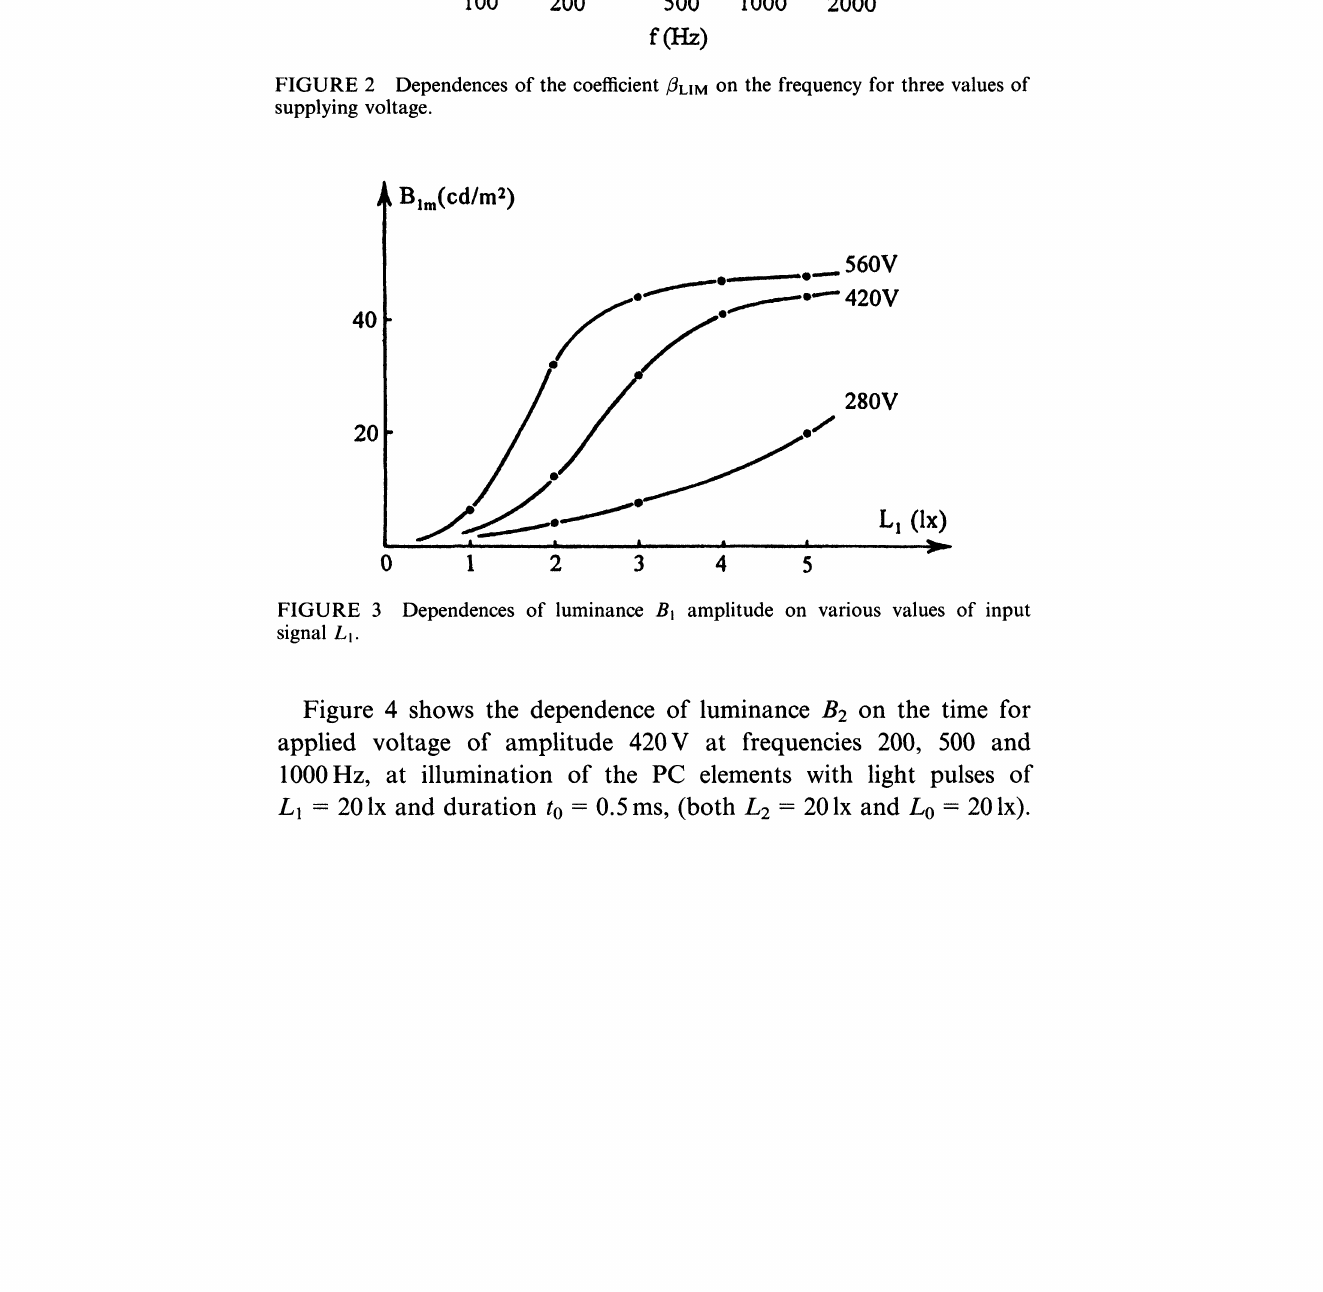
FIGURE 2 Dependences of the coefficient LIM on the frequency for three values of supplying voltage.